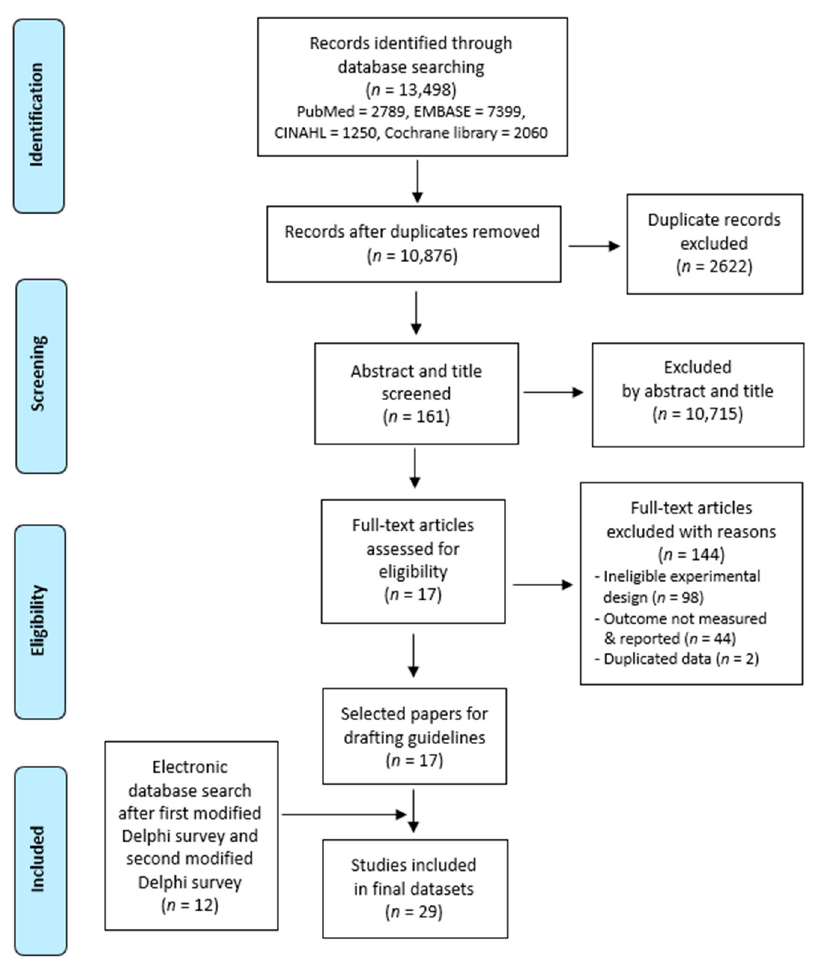
Figure 1. Flow diagram showing the identification of relevant literature in the PRISMA-ScR for- mat.